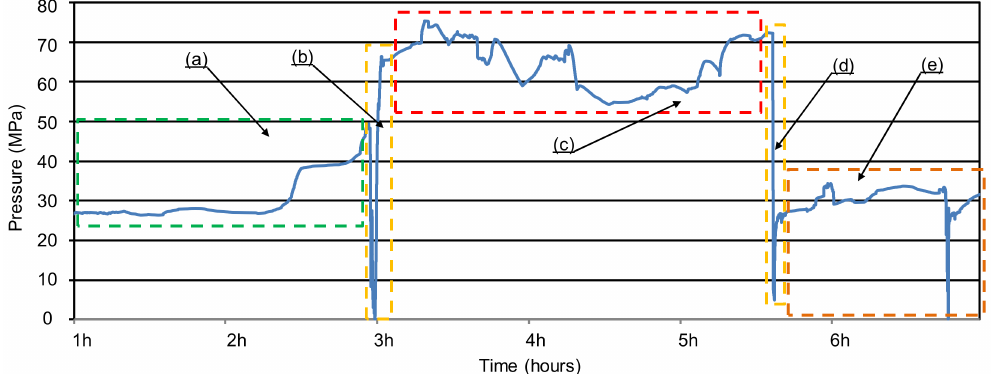
Figure 4. Measuring the pressure in the over-piston space when the housing is loaded: (a) operation of the housing with working supports, (b) cycle of shifting sections of mechanized housing, (c) obtained working support during the lapping of the housing, (d) time of moving the section to a new position, and (e) working capacity within the limits of normal